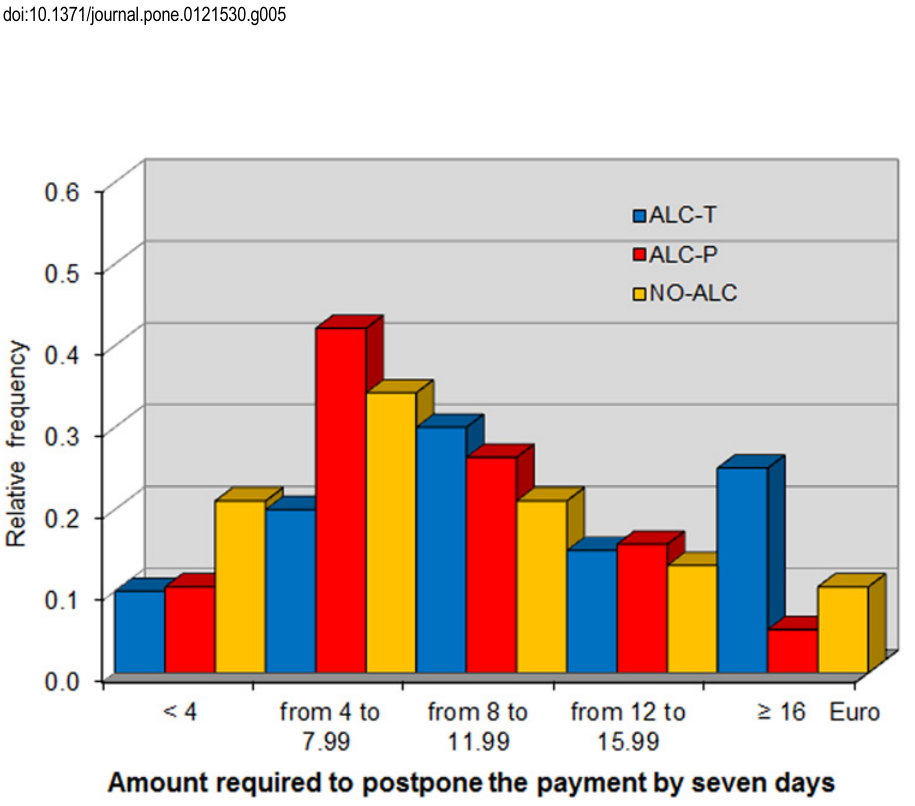
Fig 6. Distribution of additional sum required to postpone payment by seven